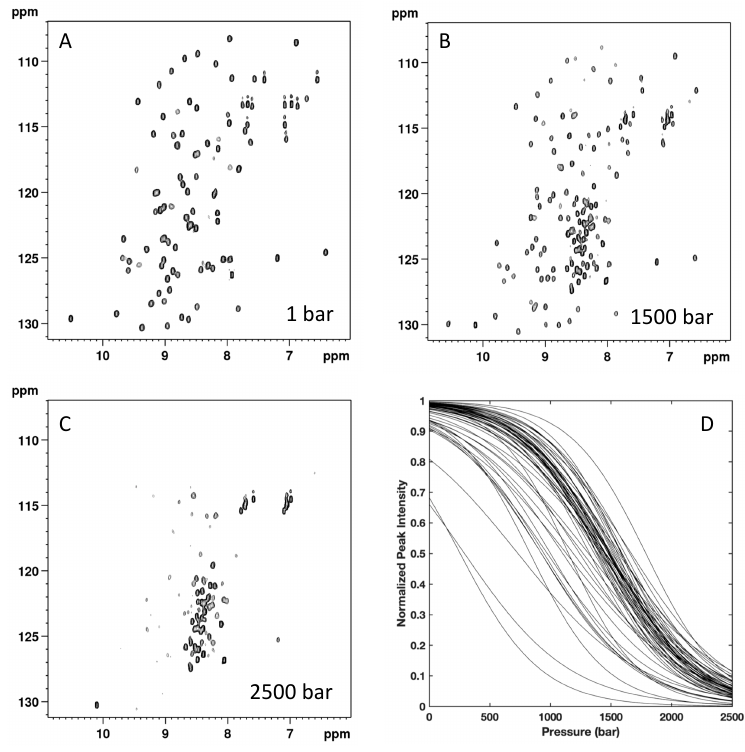
Figure 4. Nuclear magnetic resonance-detected high-pressure unfolding of DEN4-ED3 at 10 °C and 0.5 M guanidinium chloride. ( A–C ) Examples of { 1 H- 15 N} HSQC NMR spectra at di ff erent pressures as indicated; ( D ) overlay of the normalized residue-specific denaturation curves as obtained from the